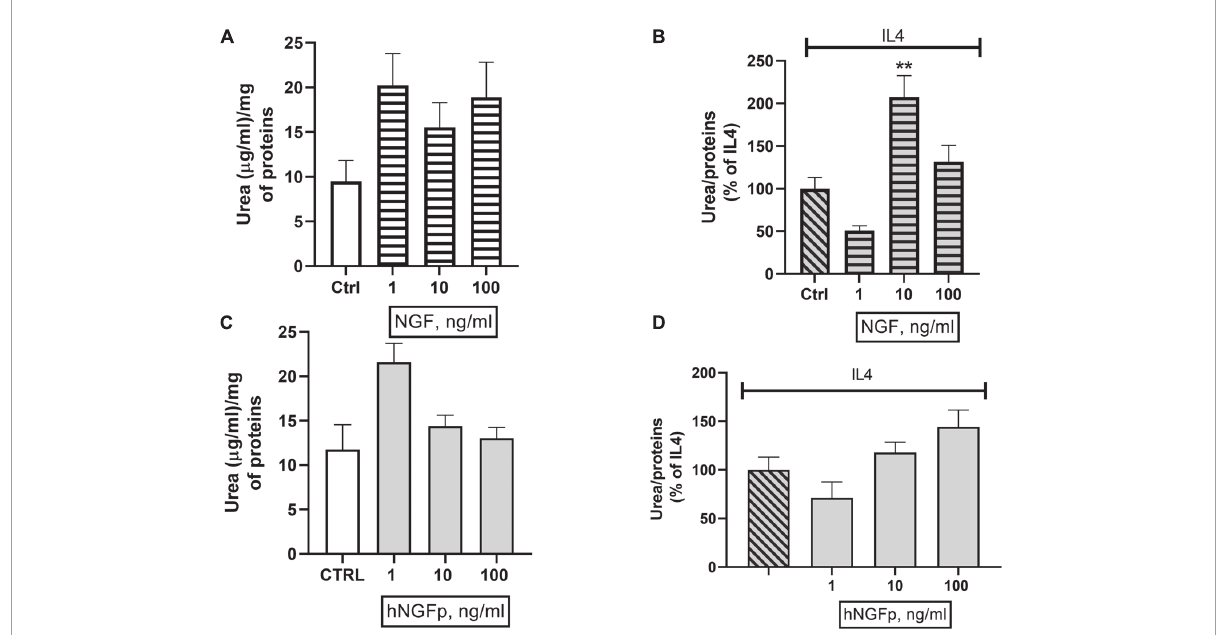
FIGURE7 Effects on urea pathway after 48 h nerve growth factor (NGF) treatments in Imhu. (A,B) The effects of 1–10 or 100 ng/ml of wild type NGF on urea production under basal condition and in co-stimulation with IL4 respectively. (C,D) The effects of 1–10 or 100 ng/ml of painless human Nerve Growth Factor (hNGFp) on urea production under basal condition and in co-stimulation with IL4 respectively. ** p < 0.01 vs. IL4. One-way ANOVA analysis followed by Bonferroni’s post-test was carried out. (B) F (3, 13) = 12.02; P = 0.0005. Data are expressed as mean ± SEM. The experiment was repeated two times with similar